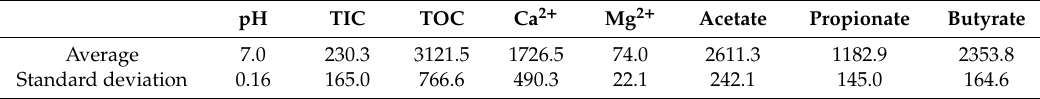
Table 1. The properties of the synthetic leachate for groups G, N, and L (mg L -1 , except pH value). Table 2. The properties of the synthetic leachate for group H (mg L − 1 , except pH